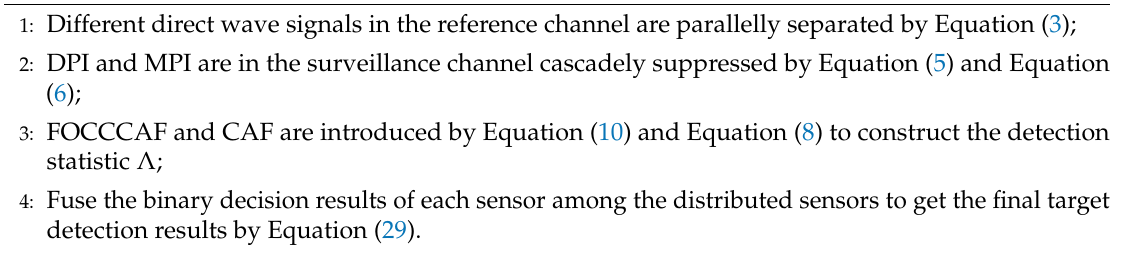
Algorithm 1 The procedure of the proposed passive detection